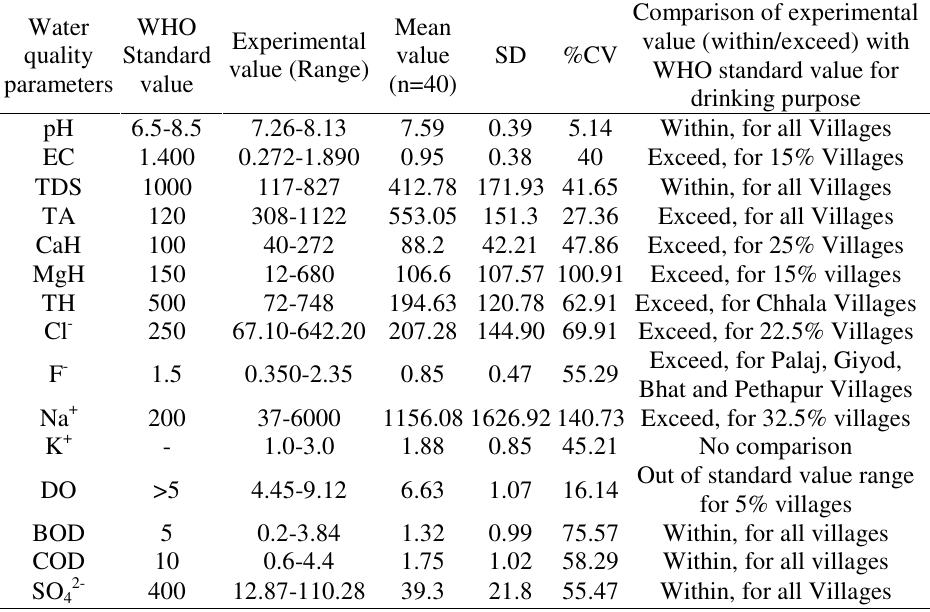
Table 3. Water quality parameters of ground water of Gandhinagar taluka